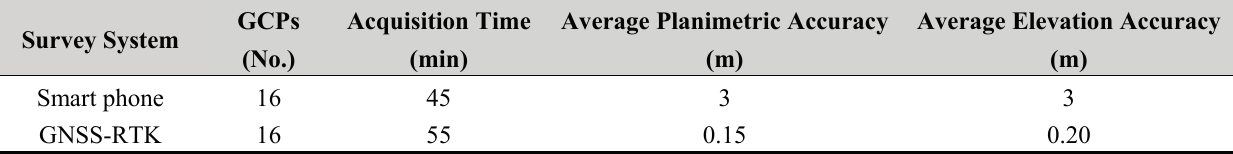
Table 4. Time required for ground control point (GCP) survey and average estimated accuracy. RTK, real-time